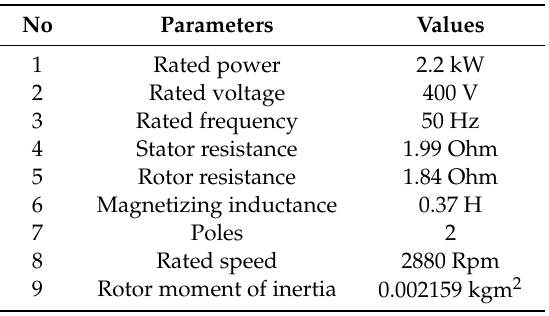
Table 1. Induction motor parameters—Siemens (1LA 7096-2AA60-Z).